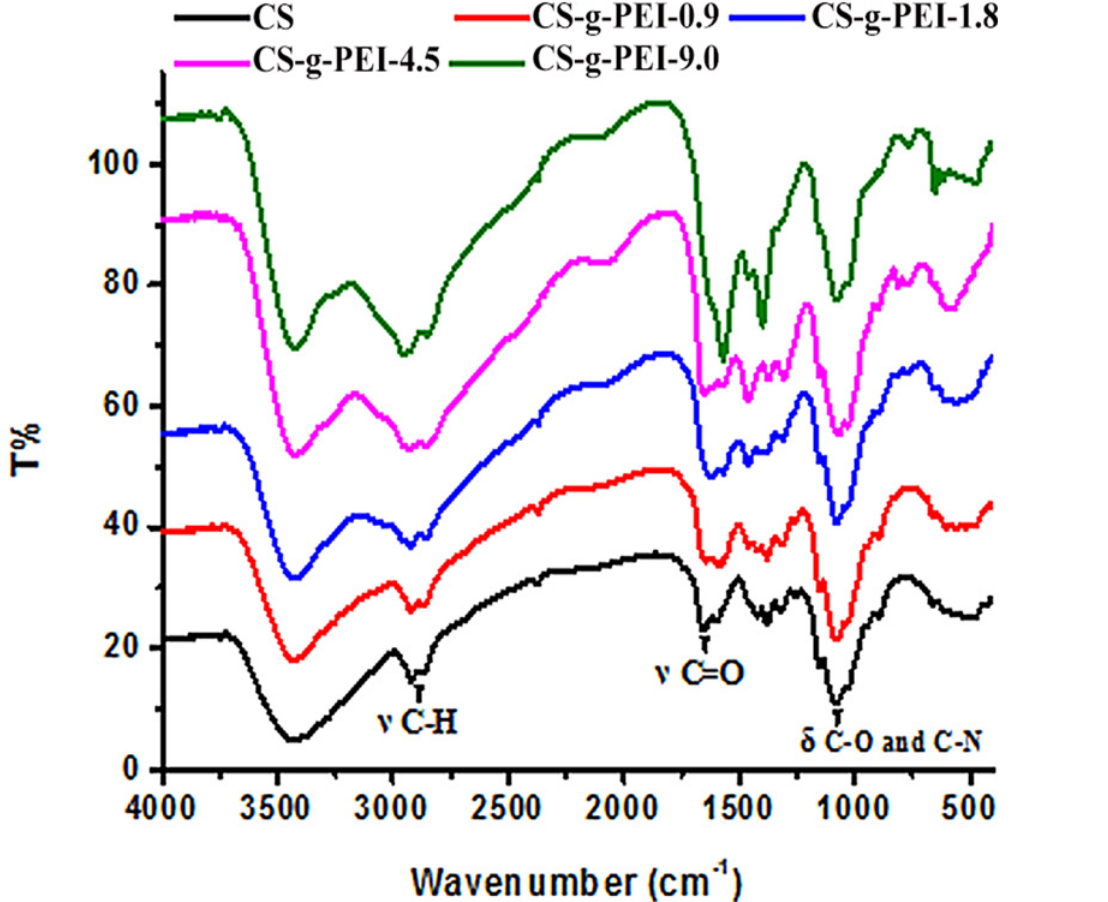
Fig 4. FTIR spectra of CS and CS- g -PEI copolymers with different grafting degrees.